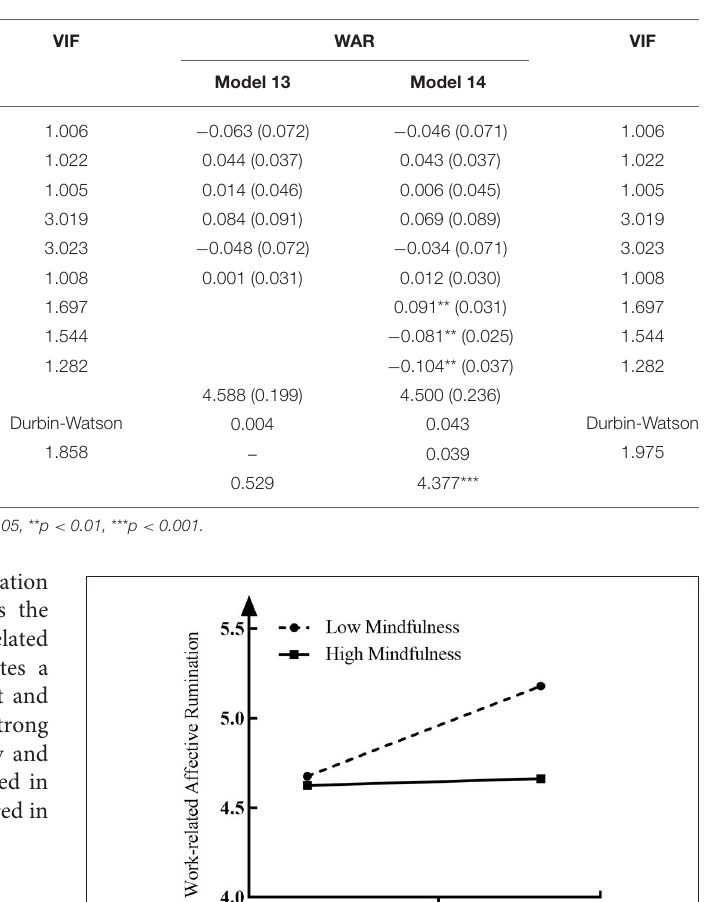
TABLE 5 | The moderating effect of mindfulness.